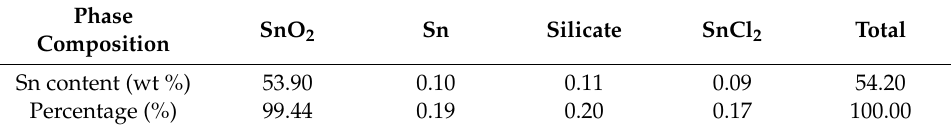
Table 1. Main chemical composition of lead refining dross (wt %). Table 2. Tin phase composition of the lead refining dross.